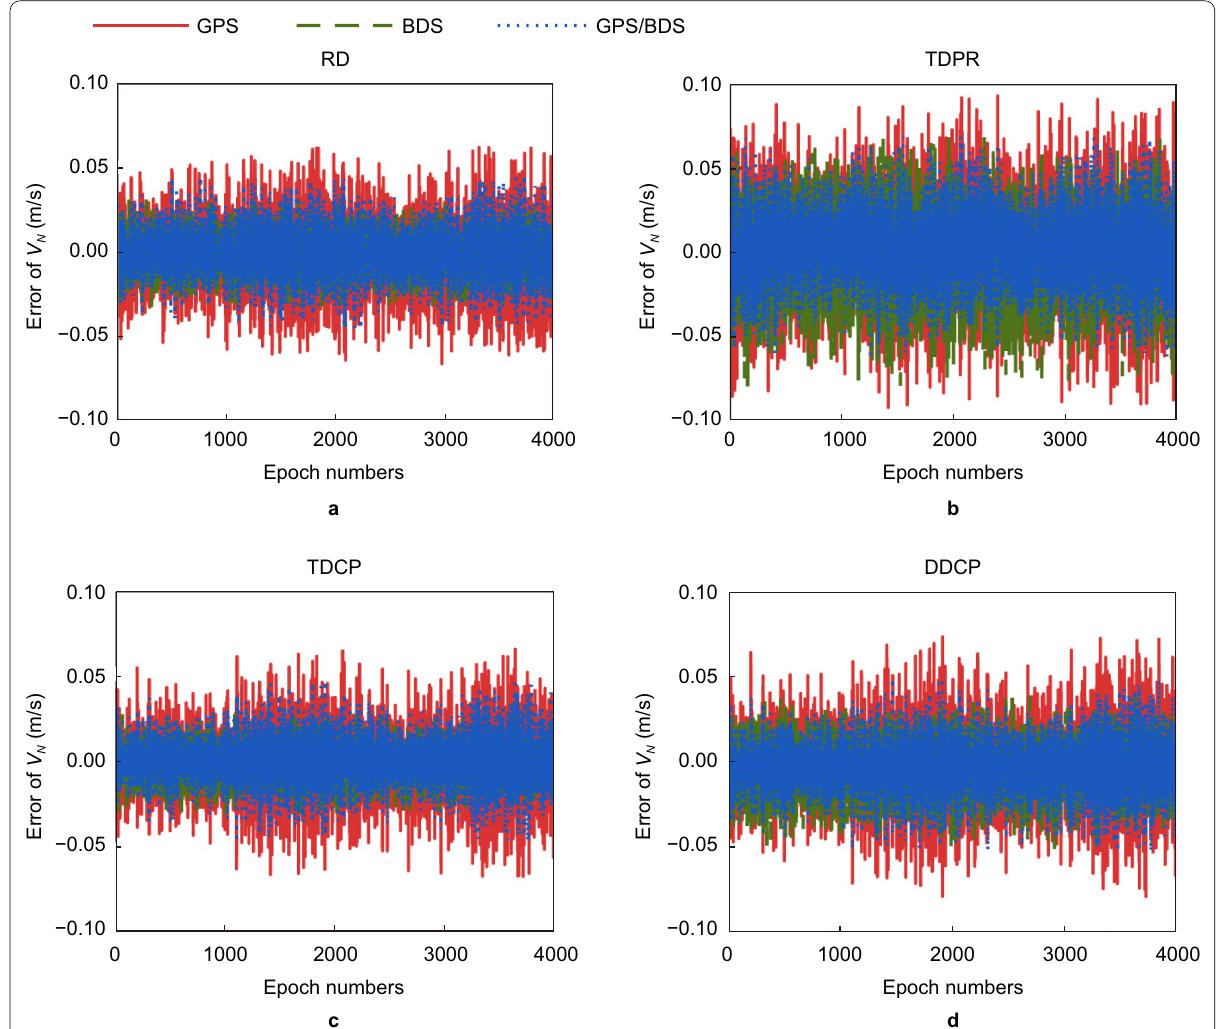
Fig. 2 Velocity determination results in north component with the RD- ( a ), TDPR- ( b ), TDCP- ( c ) and DDCP- ( d ) based methods in a static